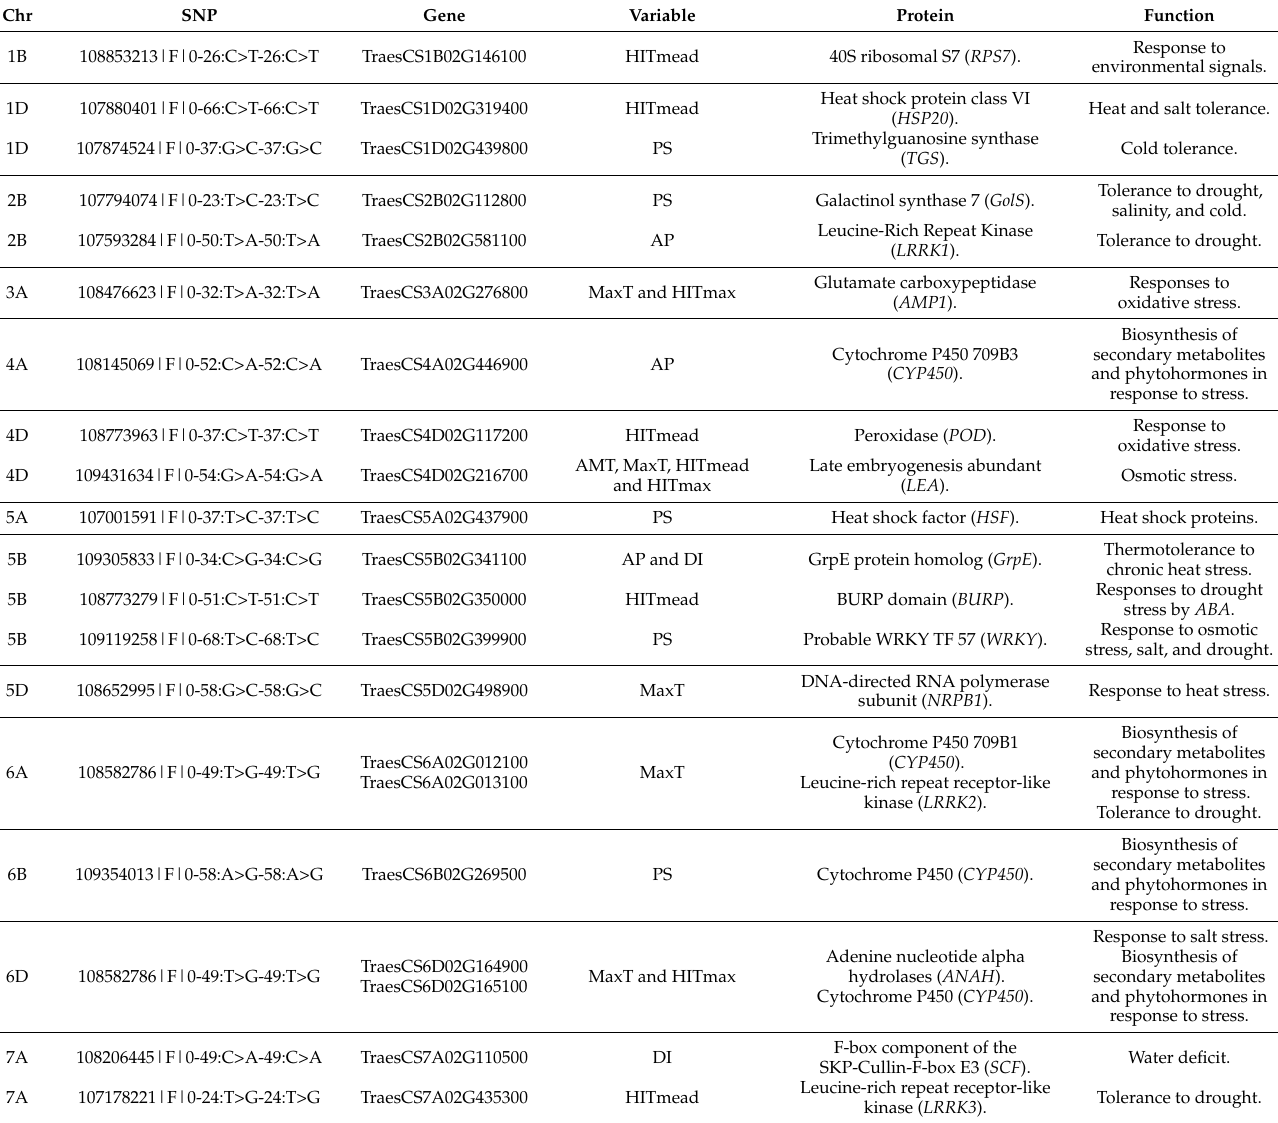
Table 5. Abiotic stress genes and proteins identified for Genome–environment Associations (GEA) with seven climatic